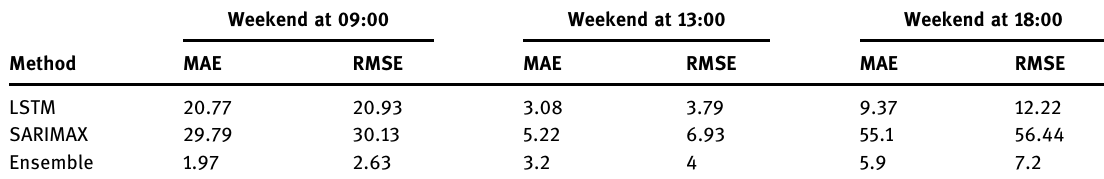
Table 4: Evaluation of methods with visitor trend data on weekend Weekend at 09:00 Weekend at 13:00